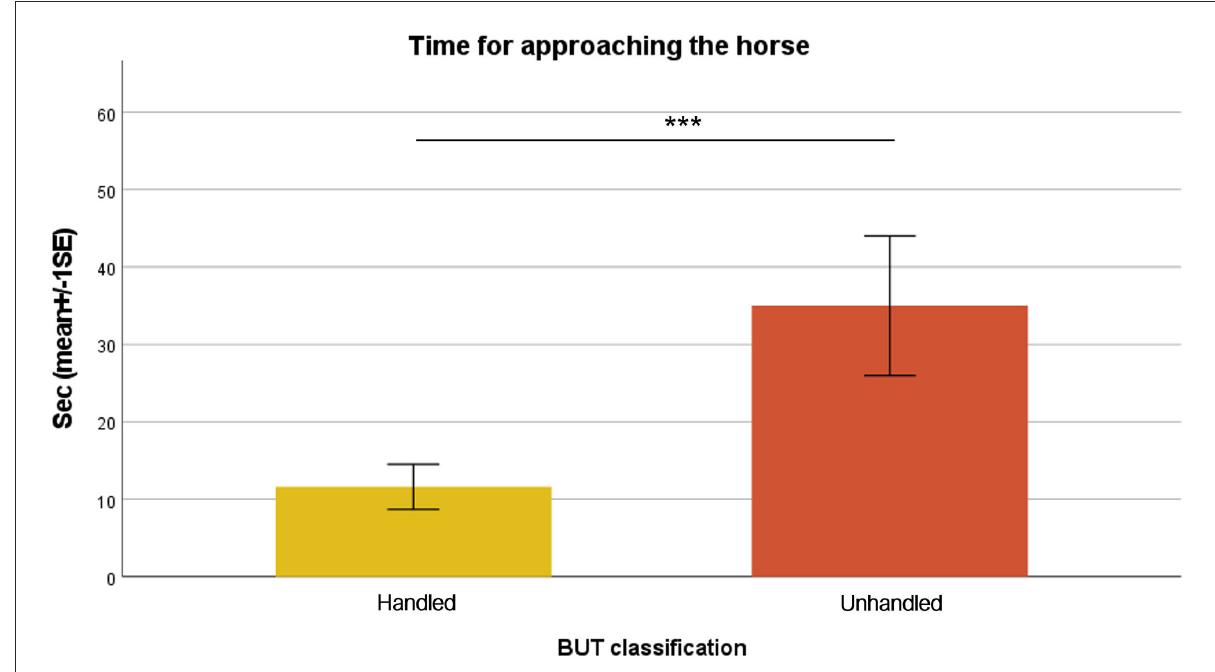
FIGURE1 Mean and standard errors of time for approaching(s). The level of significance was set at *** p < 0.001.